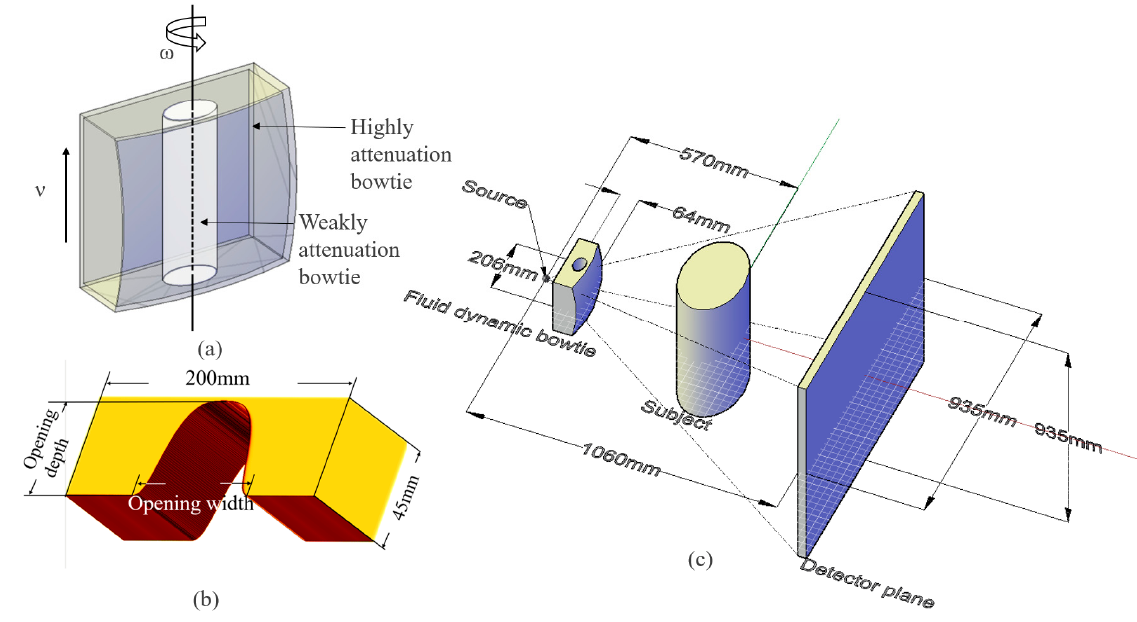
Figure 1. Geometry of the fluid dynamic bowtie ( a ), static bowtie filter ( b ) and a cone-beam CT scanner with a flat panel detector plate ( c ). Table 1. Material composition inside of the FDB [27] .